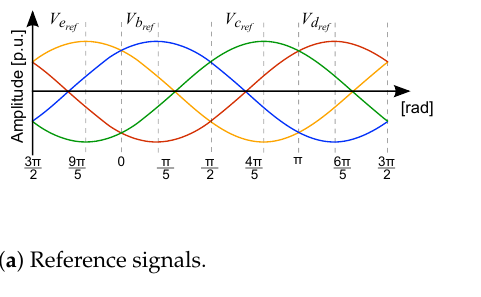
Figure 3. S − PWM scheme. Table 1. Vector application times in each S-PWM technique